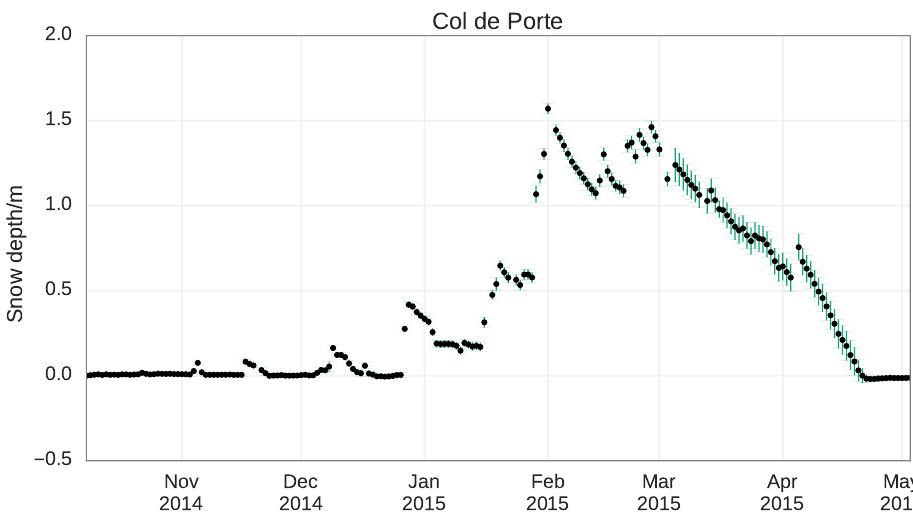
Figure 3. Evolution of the mean (black) and standard deviation (green) of the snow depth at Col de Porte over the winter season 2014–2015 measured by the